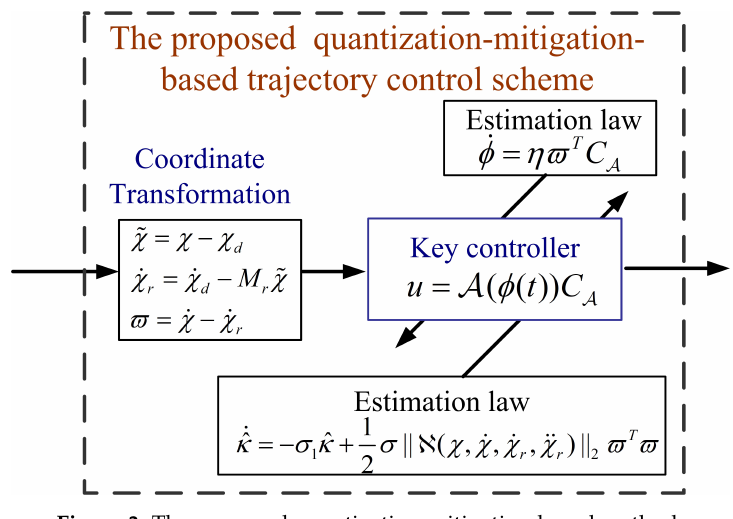
Figure 3. The proposed quantization-mitigation-based